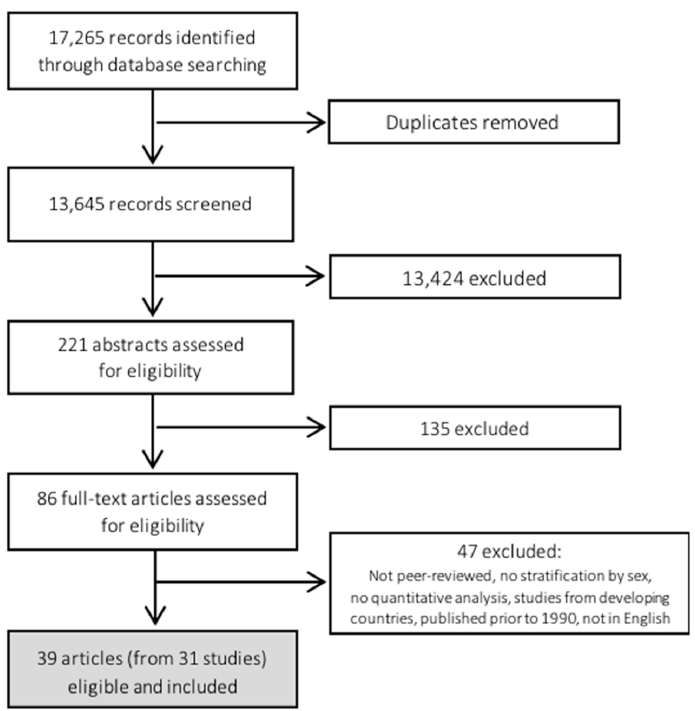
Figure 1. Overview of identification and screening of records for scoping review of literature on food insecurity and mental health among women in high-income countries.